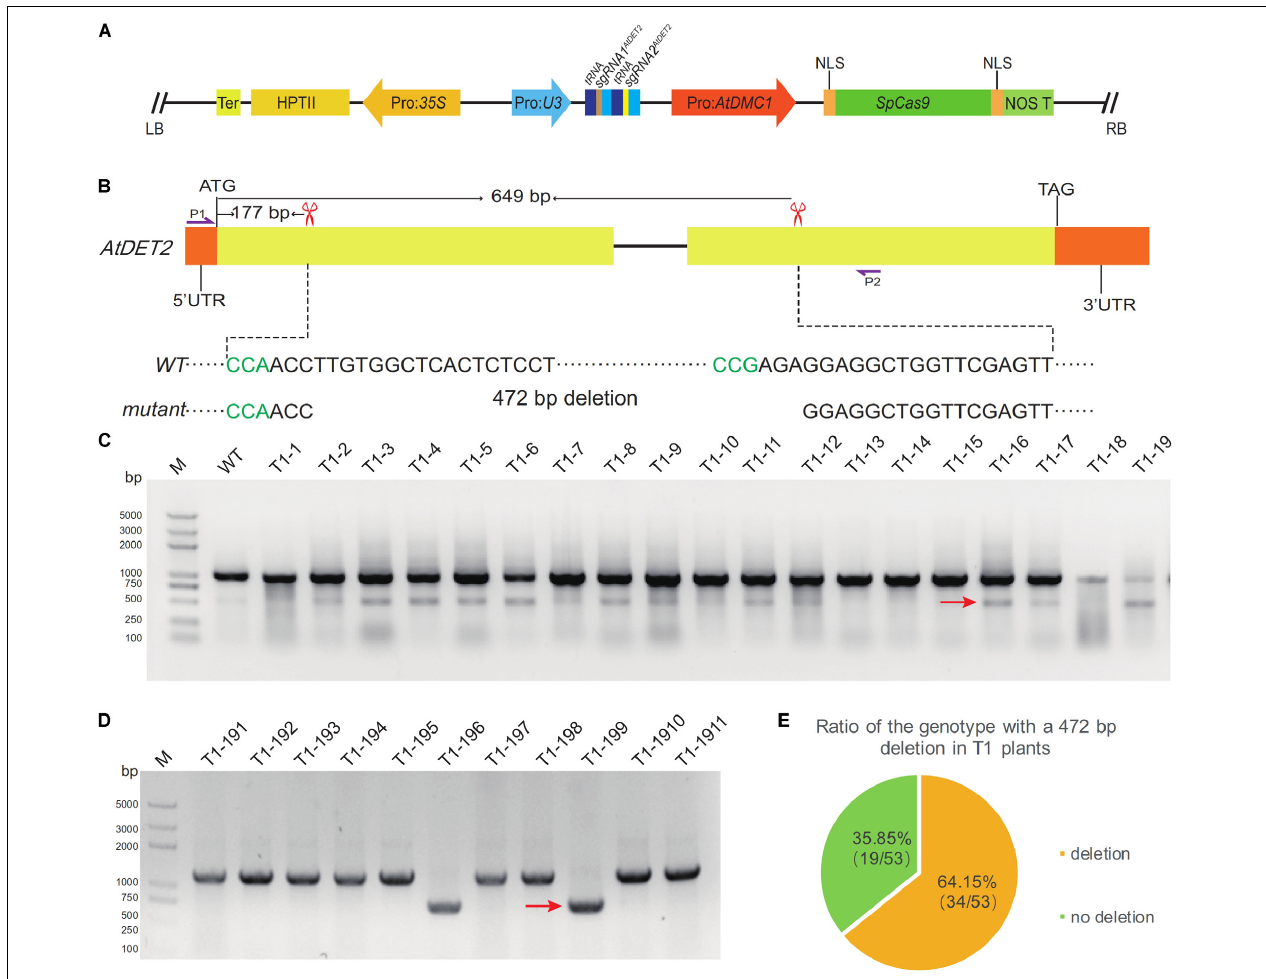
FIGURE 4 | Efficient generation of a middle size deletion by the MSC system. (A) A structural representation of the pLFC317 plasmid. (B) Two targeted sites were designed to expectedly generate a 472 bp deletion in the AtDET2 gene. The red scissors indicated the targeted sites of AtDET2 . The left black sequence is sgRNA1 AtDET2 and the right is sgRNA2 AtDET2 . The PAM sequence is shown in green. The purple arrows P1 and P2 represent the locations of primers for amplifying the DNA fragment embracing the two cleavage sites. (C) PCR detection of DNA deletion between the two targeted sites in the T1 transgenic plants. Successful deletions were shown as shorter PCR products (indicated with red arrow). (D) The deletion was indicated by the results of colony PCR. The red arrow represents PCR products with deletion. (E) The deletion frequency in T1 transgenic plants.